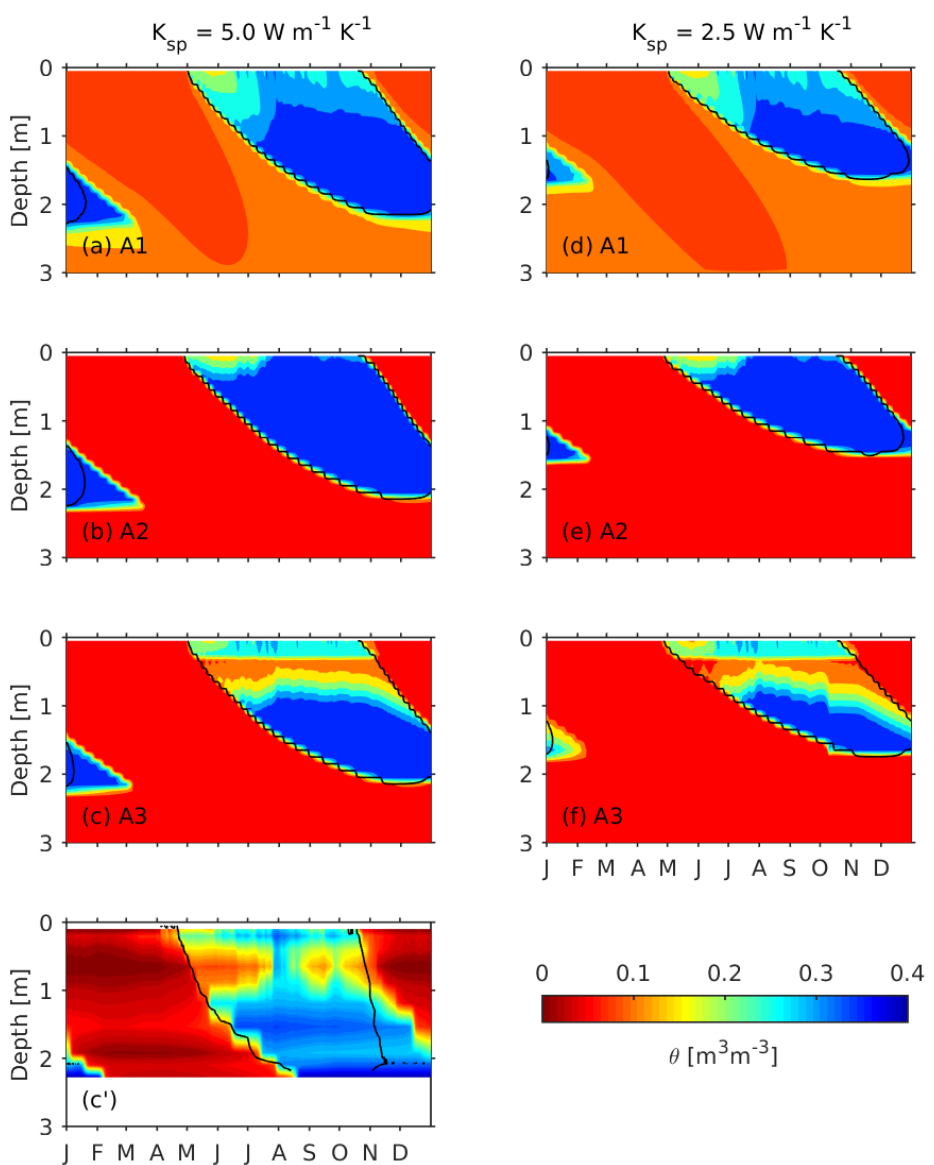
Figure 9. Comparison of the simulated unfrozen soil water content (colour) and the 0 ◦ C-isotherm (black line) in the active layer with different soil architectures and thermal conductivities ( λ sp ) in 2008. The rows correspond to different architectures of the soil: (a, d) single fine-grained layer (A1), (b, e) single coarse-grained layer (A2), (c, f) two layer structure (A3). The panels correspond to λ sp = 5.0Wm − 1 K − 1 (left) and λ sp = 2.5Wm − 1 K − 1 (right). (c’) Observed case (same as Fig.